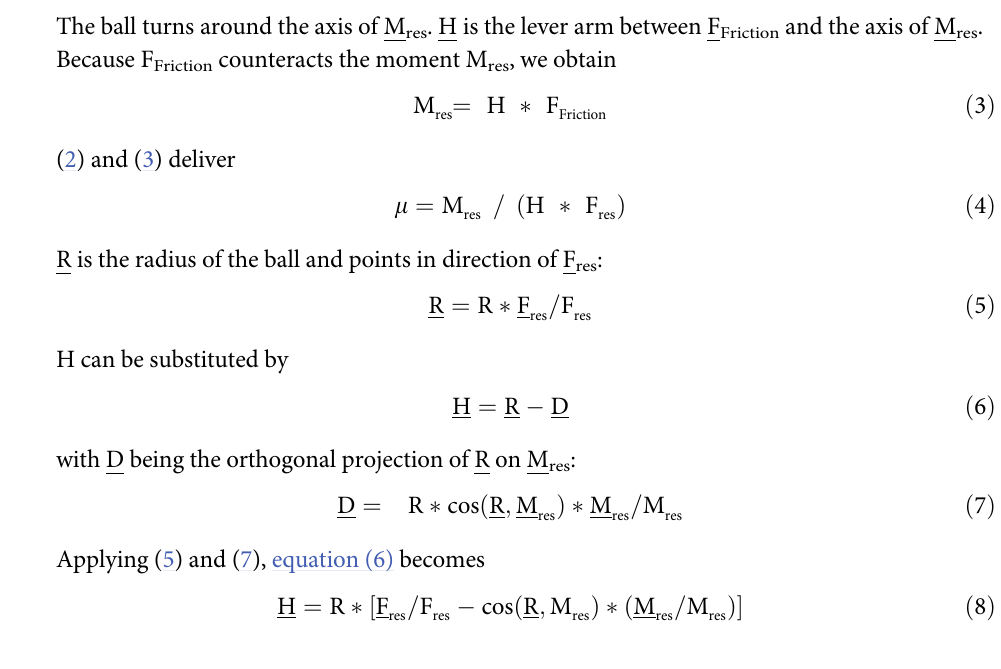
The coef fi cient of correlation (R²) and the residual-standard-error (RSE) were calculated and statistically analyzed with a t-test. For all statistical calculations a type-I-error level was de fi ned with α = 0.05.